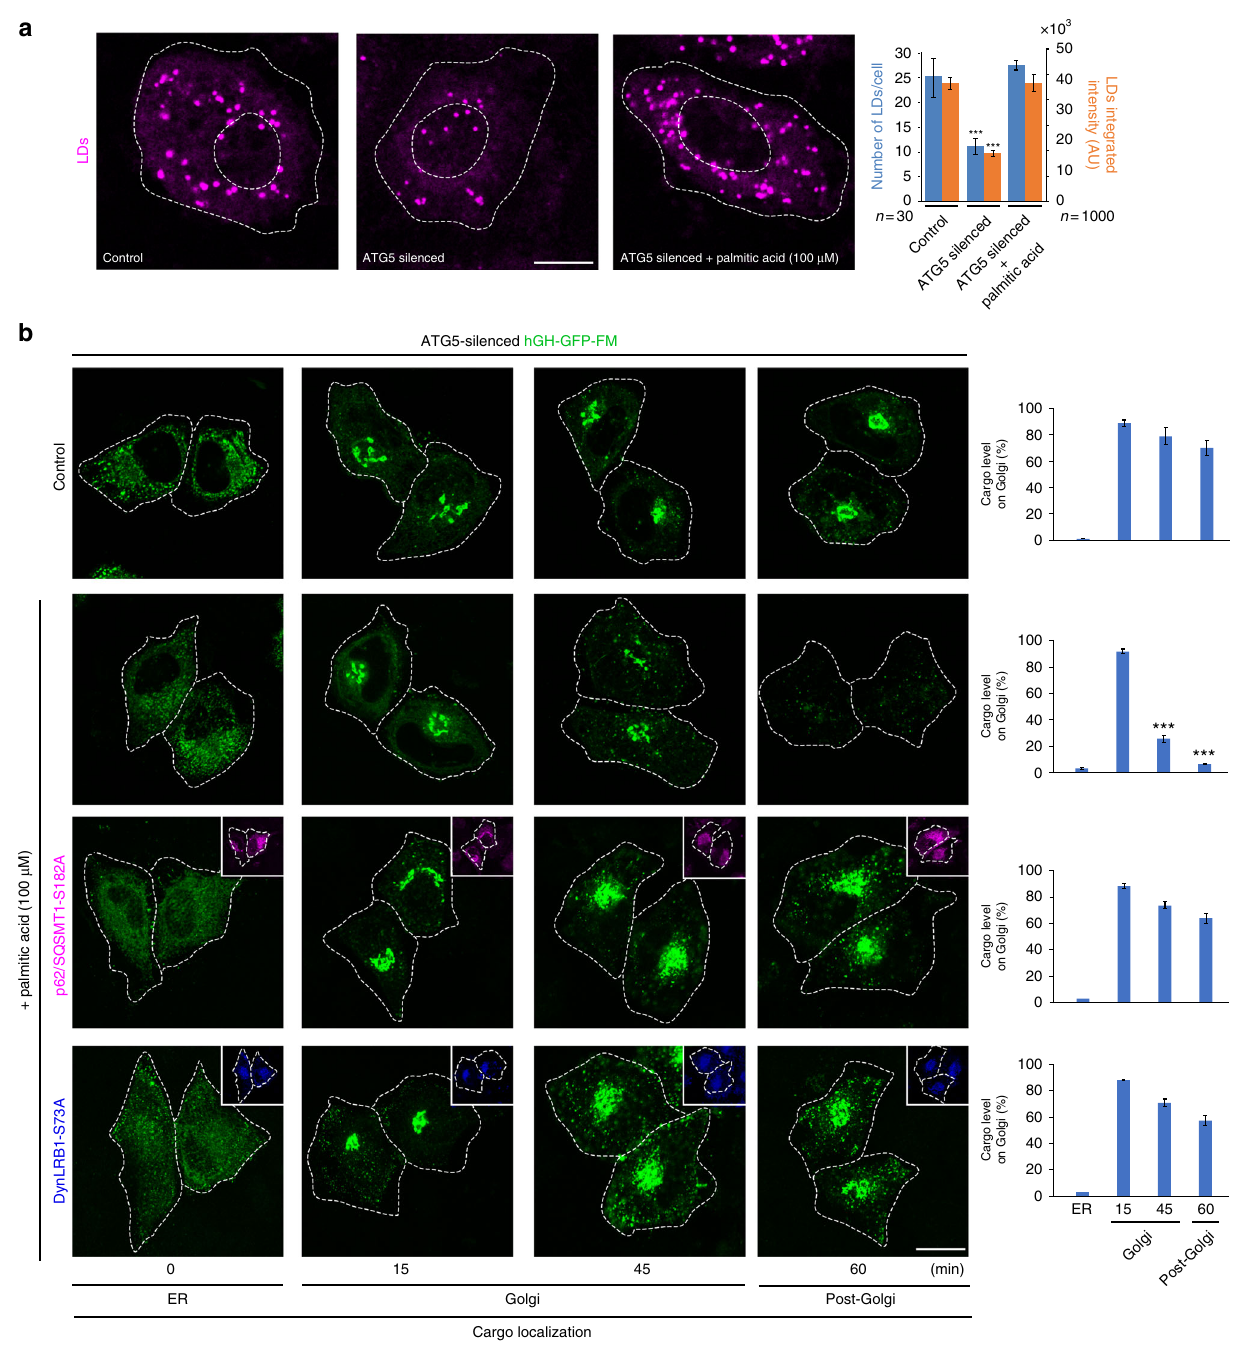
Fig. 9 Autophagy-dependent lipid droplet turnover affects protein secretion. a HeLa cells expressing human growth hormone fused to the polymerization/ depolymerization FM domain (hGH-GFP-FM) were left untreated (Control) or subjected to ATG5 silencing (ATG5 silenced) and kept in normal media (Control and ATG5 silenced) or incubated for 4h in media supplemented with 100 µ M palmitic acid (third image), followed by lipid droplet (LD) staining with BODIPY. Scale bar, 10 µ m. The graph shows the quanti fi cation of the number and fl uorescence intensity of LDs ( n = 1000 LDs) of cells ( n = 30 cells) subjected to the indicated treatments, from images as those shown at the left. b HeLa cells expressing hGH-GFP-FM were subjected to ATG5 silencing and left without further transfection (upper two panels) or transfected to co-express either p62/SQSMT1-mcherry-S182A or DynLRB1-HA-S73A. Cells were kept in normal media (Control, fi rst panel) or incubated for 4 h in media supplemented with 100 µ M palmitic acid (lower three panels), followed by the ER- to-Golgi transport assay. Cells were fi xed (upper three panels) or fi xed and permeabilized, followed by immuno-staining with antibody to detect DynLRB1- HA-S73A. Representative images show hGH-GFP-FM localization in the endoplasmic reticulum (ER), Golgi or post-Golgi at the indicated times after addition of DD-solubilizer. The respective graph in each panel depicts the quanti fi cation of hGH-GFP-FM in the Golgi complex at the times indicated in images as those shown at the left ( n = 30 cells). Scale bar, 10 µ m. Data are means ± SEM. *** p < 0.001 (Student ’ s t tests). All t tests were conducted comparing to control cells. HA